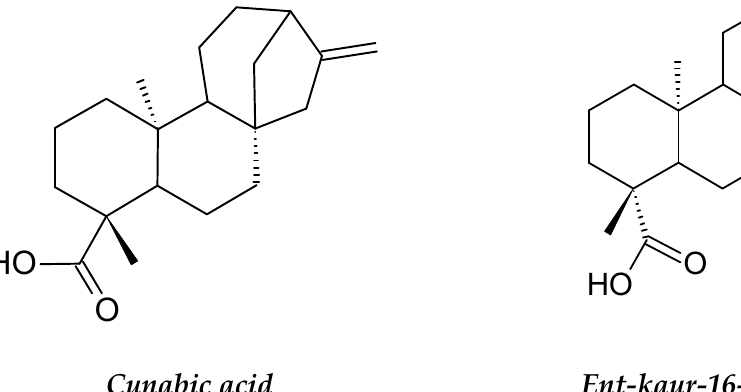
Figure 7. The structures of cunabic acid and Ent-kaur-16-en-19-oic acid. Screening of the phytochemical constituents of the ethanolic extracts of A. glabra leaves showed that the plant leaves contain terpenoids, flavonoids, saponins, glycosides, anthraquinones, steroids, tannins and acidic compounds, and do not contain alkaloids, phlobatanin or reducing sugars [64]. The methanolic extracts of A. glabra fruit contain dihydrophaseic acid β -d-glucopyranoside, dihydroxybenzoic acid, dimethoxyphenyl β -d- glucopyranoside, icariside D2-d-xylopyranoside, cucumegastigmane I, blumenol A and cytotoxic effect on HL-60 cell line is icariside D2 [62]. Indisputably, based on the